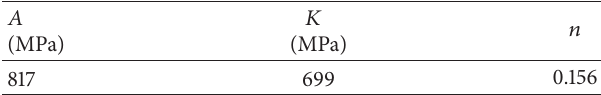
Table 3: AISI 4140 Ludwik